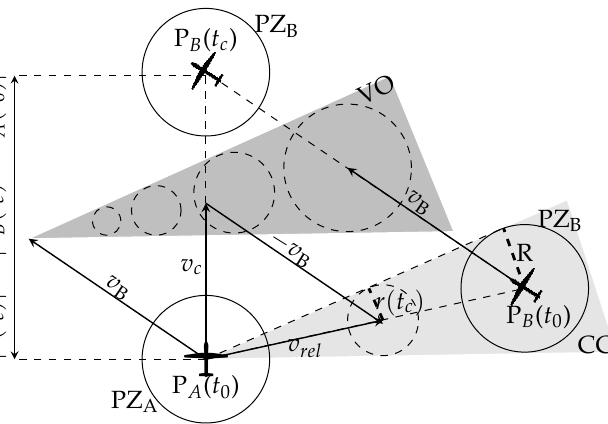
Figure 7. Representation of a velocity obstacle (VO) imposed by intruder B, and the relationship between a circular velocity vector set and the protected zone (PZ) [41]. By adding the intruder’s velocity, the collision cone (CC) is translated, forming the intruder’s VO.